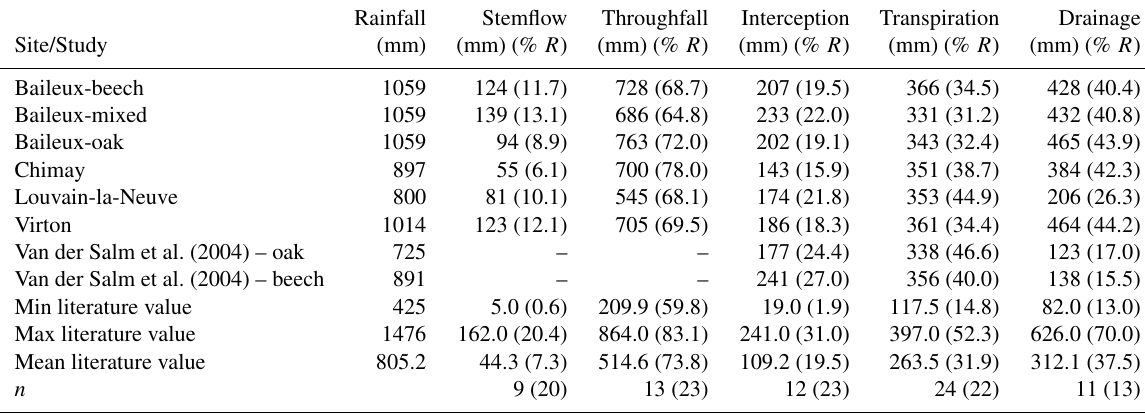
Table 4. Predicted annual water fluxes and the corresponding percentage of rainfall in brackets for the different study sites during the period 2002–2016. The minimum, maximum and mean values from literature are indicated with the number of studies ( n ) they are based on. The studies taken into account were restricted to sites dominated by beech or by oak in temperate regions with similar meteorological conditions. Data from the same site were averaged so that long monitoring studies do not influence the average value too